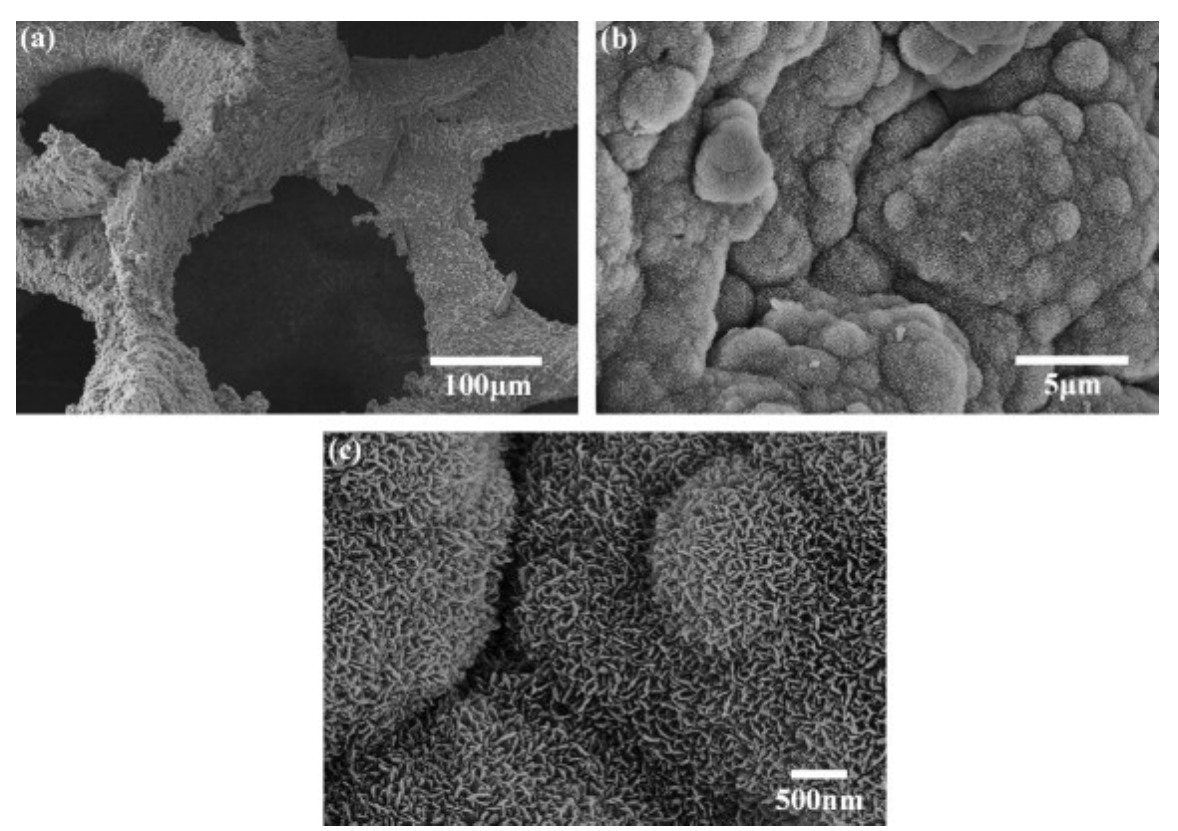
Figure 3. SEM images of the surface of a 13–93 glass scaffold fabricated by a foam replication method, after immersion for 7 days in SBF: (a) lower magnification image; and (b, c) higher magnification image showing fine needle-like hydroxyapatite crystals [105]. Figure reprinted with permission of